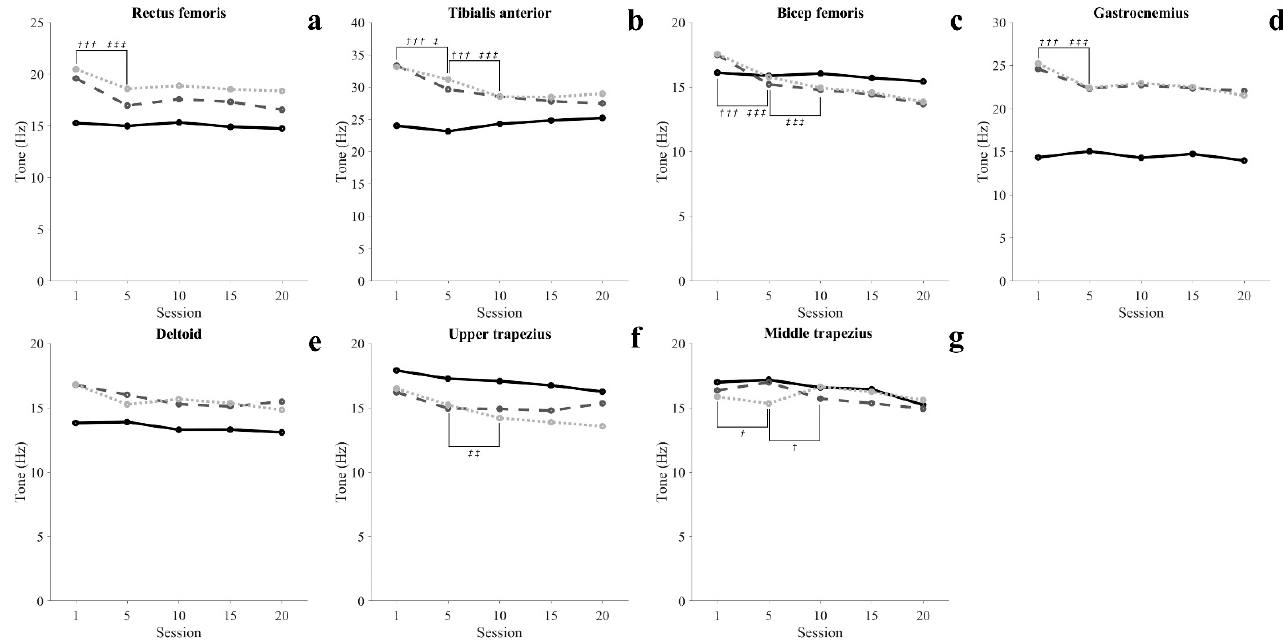
Figure 4. Time-series graphs of significant difference periods for muscle tone (sitting position: solid line; standing position: dashed line; wide standing position: dotted line). † Significant differences in a standing position, † = p < 0.05, ††† = p < 0.001. ‡ Significant differences in a wide standing position, ‡ = p < 0.05, ‡‡ = p < 0.01, ‡‡‡ = p < 0.001.